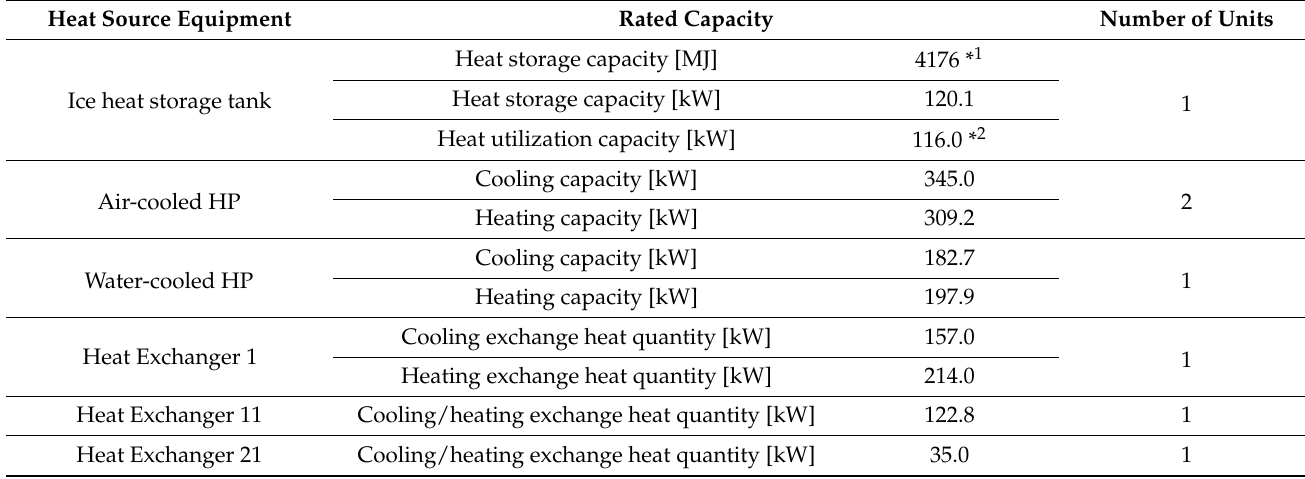
Table A2. Specifications of heat source